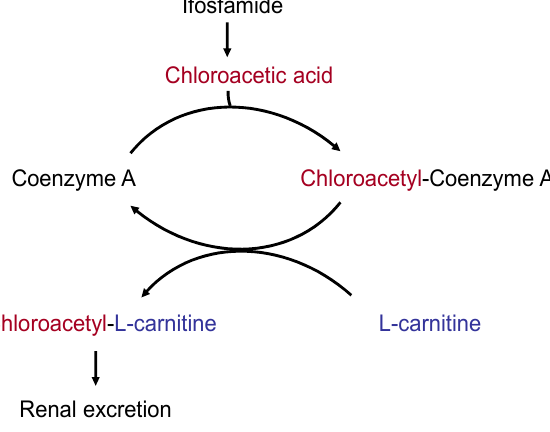
Figure 2. Ifosfamide and carnitine depletion [171].